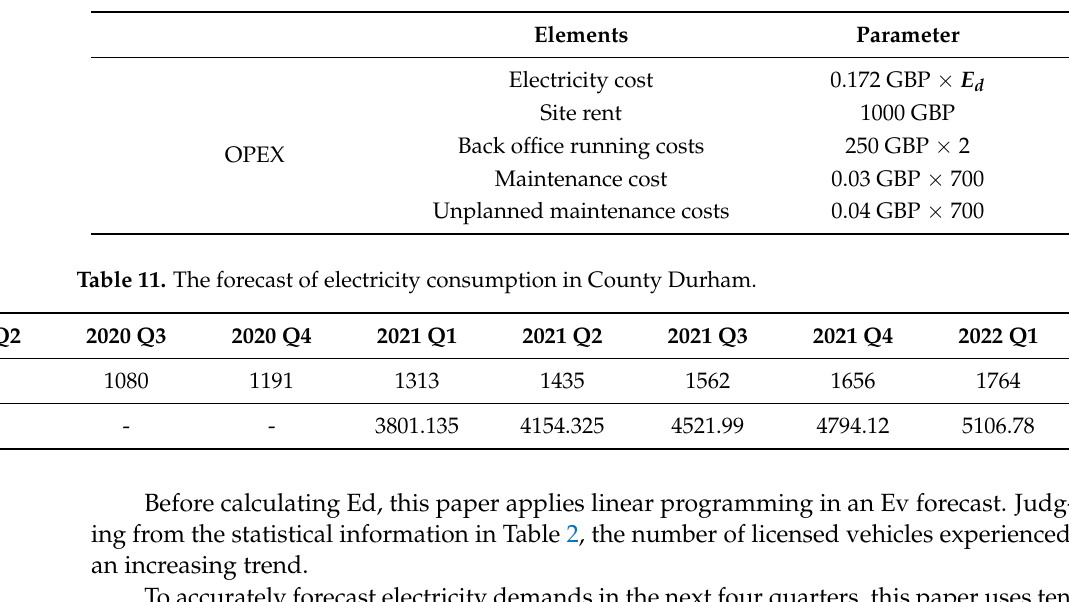
Table 10. OPEX of a charging station in the rural area (annual).